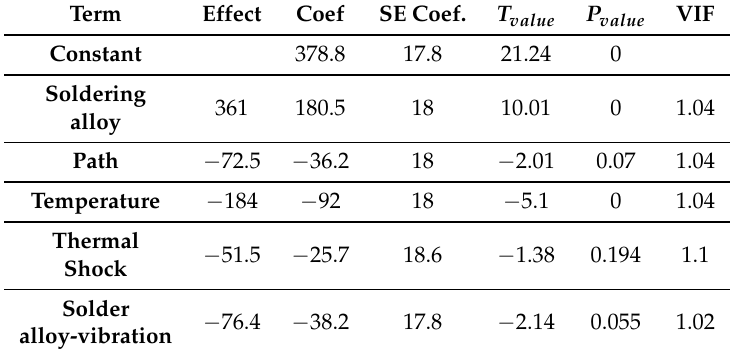
Table 4. Coefficients of the model.